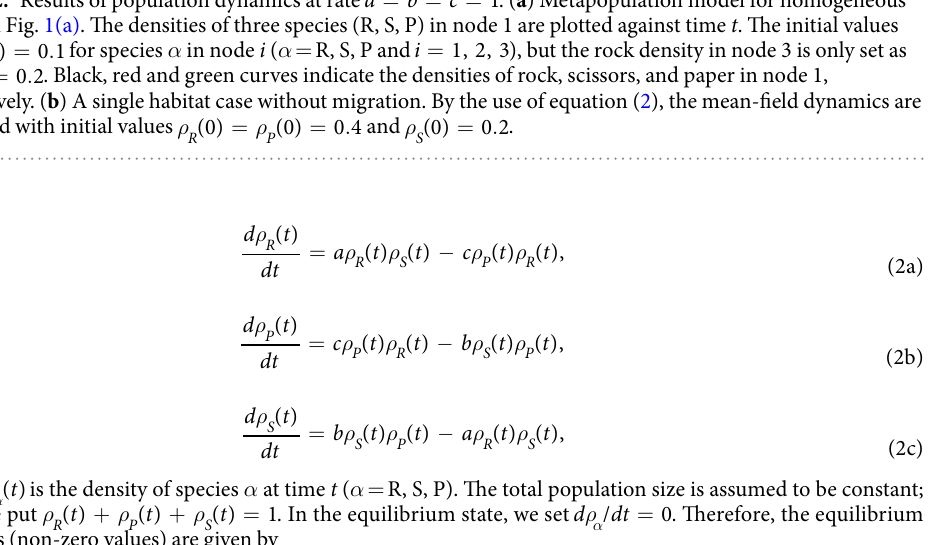
S where ρ t ( ) is the density of species α at time t ( α = R, S, P). The total population size is assumed to be constant; α thus, we put ρ ρ ρ + + = t t t ( ) ( ) ( ) 1 . In the equilibrium state, we set ρ = d dt / 0 . Therefore, the equilibrium α R P S densities (non-zero values) are given by ρ ρ ρ = + + = + + = + + . b a b c a a b c c a b c /( ), /( ), /( ) (3) R e P e S e , , , If = = = a b c 1 (standard RPS game), then all densities take the same value (1/3). The equilibrium state is not stable 37 . The density of each species periodically oscillates around the equilibrium density. The time average of a species density over one period is given by equation (3). Next, we consider metapopulation models which have N nodes ( ≥ N 2 ). Population dynamics are expected to be different whether the network is homogeneous or heterogeneous. When all nodes have the same degree (num- ber of links), we call it homogeneous. We choose N = 3, because it is the simplest case to have both homogeneous and heterogeneous graphs. In Fig. 1, three circles mean habitats (nodes), and lines denote paths (links). The whole population consists of three nodes ( N = 3). All individuals can move their nodes along a path. Let ρ be the den- α i sity of species α in node i ( α = R, S, P and = i 1, 2, 3 ), and ρ be the total density in node i . From the definition, i we have